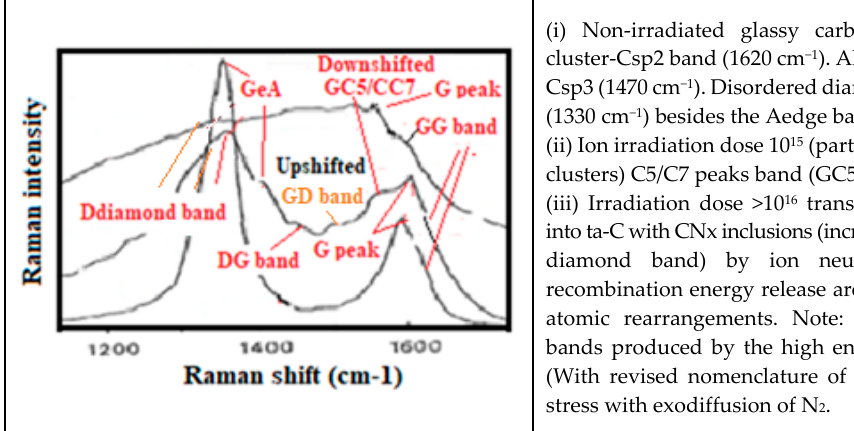
Figure 2. Glassy carbon 25 KeV N+ ion irradiated with additional annotations from M. Iwaki et al. [182] with permission of the journal of J. Mater. Res.